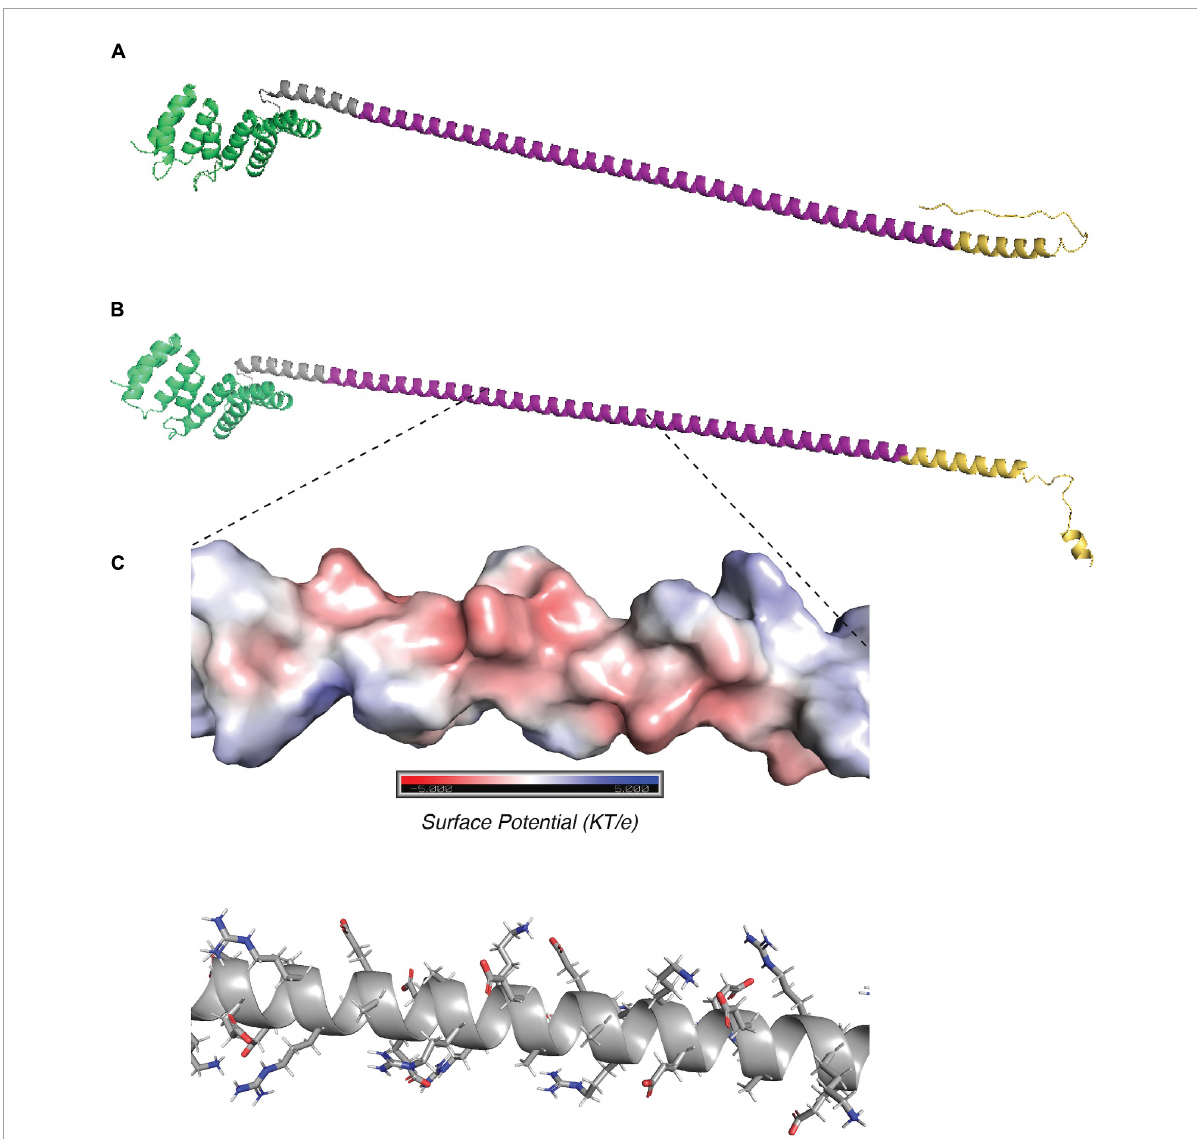
FIGURE4 Structure predictions of TP0470. (A) trRosetta and (B) AlphaFold predictions of structure of 15 repeat TP0470 variant. N terminal tetratricopeptide repeat domain is shown in green, repeats are in purple, and C-terminal region is in gold. (C) APBS electrostatic surface potential (top) and stick model of sidechains (bottom) for portion of repeat